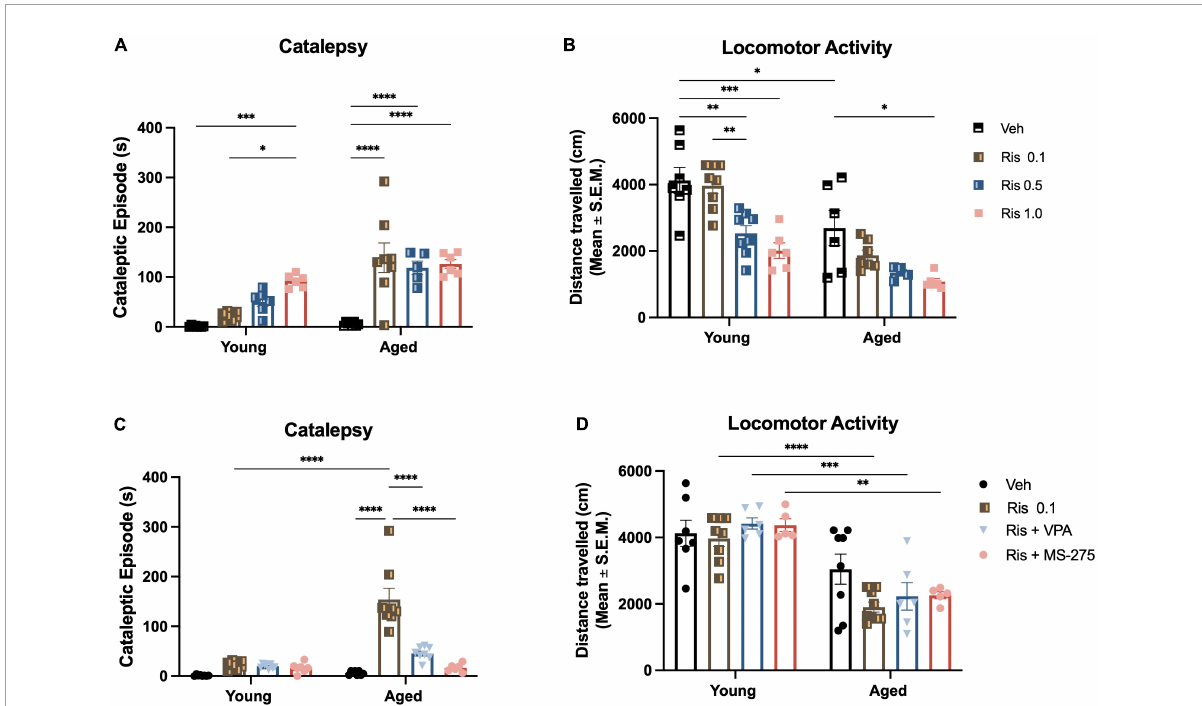
FIGURE1 Risperidone induces a dose response of motor side effects in aged mice and histone deacetylase (HDAC) inhibitors could prevent the side effects. (A) Motor side effects measured by cataleptic episode in 5 min. Lower dose of RIS at 0.1 mg/kg already showed a significant increase in cataleptic behavior in aged mice but not young mice. However, the higher doses of RIS could cataleptic behavior in both young and aged mice, although more severe in aged mice. (B) General locomotor activity measured by open field. Again, the lower dose of RIS at 0.1 mg/kg displayed a decrease in the distance traveled in aged mice but not in young group. However, higher doses of RIS at 0.5 and 1.0 mg/kg induced the decreased in the distance traveled with a dose respond manner. (C) Co-treatment of lower dose of RIS (0.1 mg/kg) with VPA (400 mg/kg) or MS-275 (10 mg/kg) reduced the duration of catalepsy in aged mice. (D) Lower dose of RIS (0.1 mg/kg) with VPA (400 mg/kg) or MS-275 (10 mg/kg) did mitigate the RIS-induced decrease in locomotor activity in the young but not old mice. Data represent mean ± SEM ( n = 6–8/group). ∗ p < 0.05, ∗∗ p < 0.01, ∗∗∗ p < 0.001, ∗∗∗∗ p <